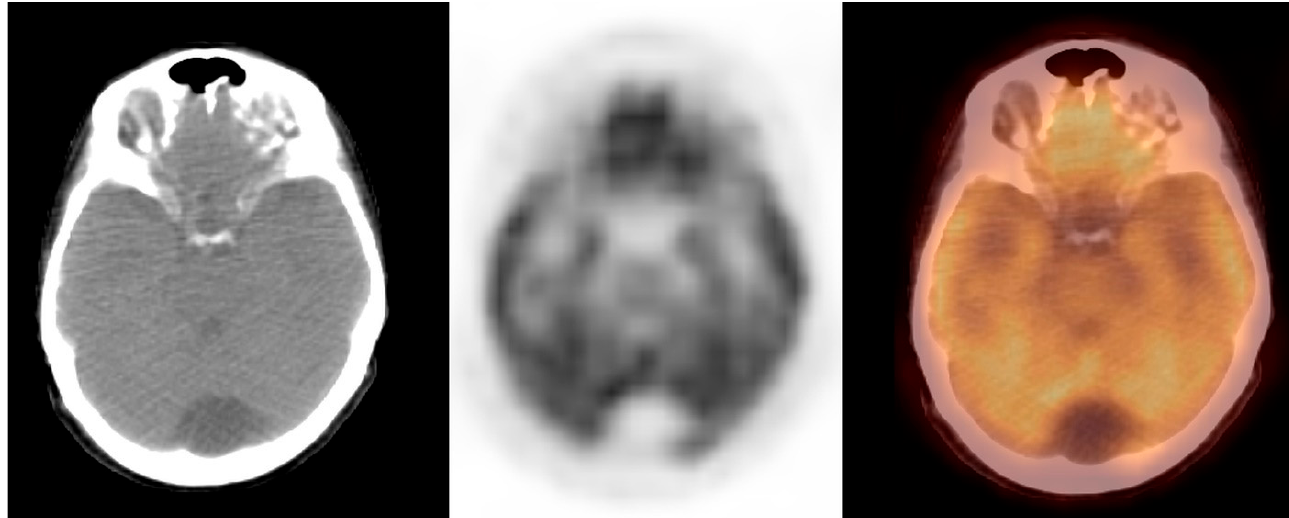
Figure 3. Incidental finding of a hypodense and photopaenic area in the posterior part of the brain in the middle cranial fossa, consistent with arachnoid cyst, in a patient with cervical cancer (source: original figure). Description: axial view of the brain and torso [ 18 F]FDG PET/CT over the middle cranial fossa—low-dose CT (left-hand side image), PET (middle image), and PET/CT fusion (right-hand side image).